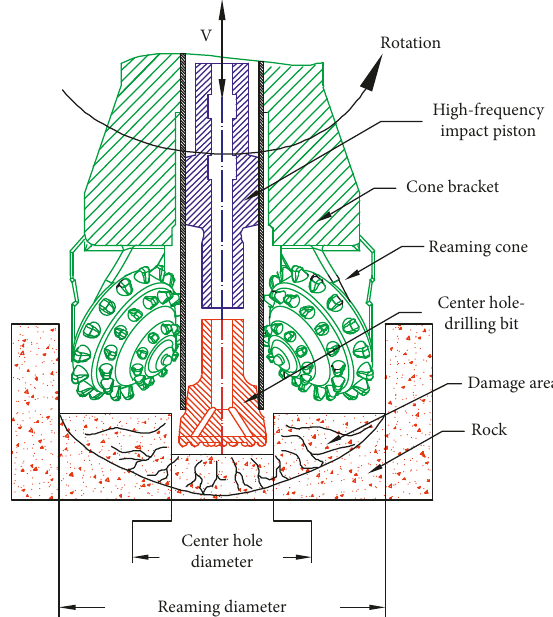
Figure 1: Schematic diagram of compound rock drilling.